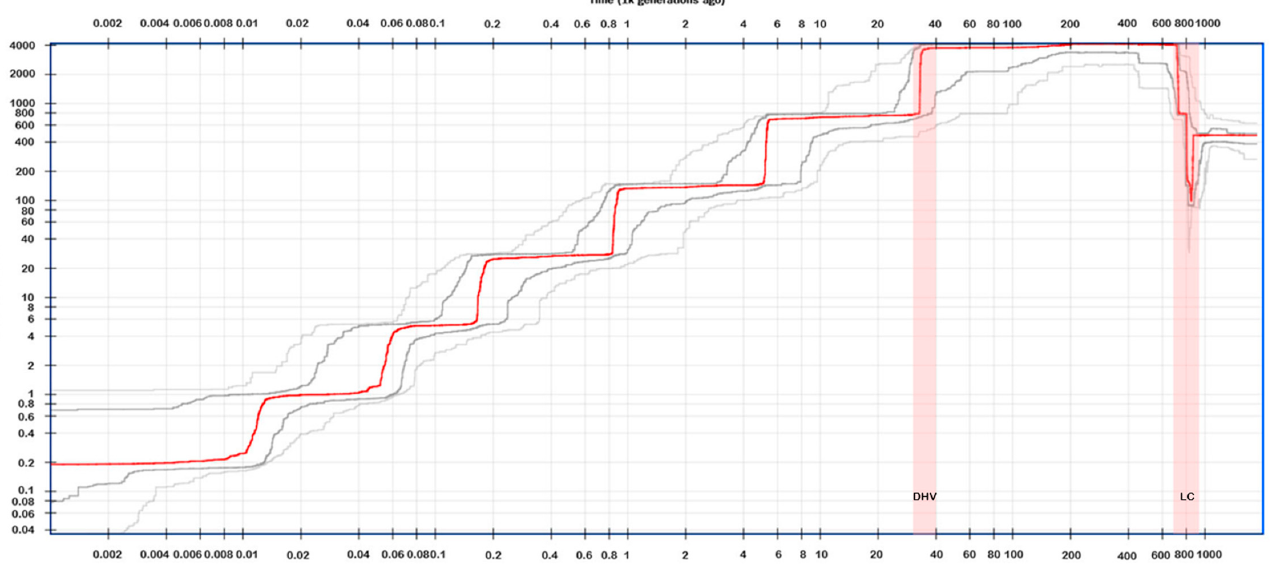
6 of 14 Figure 3. Divergence-time estimation and S-DIVA reconstruct historical biogeography: ( A ) Diver-